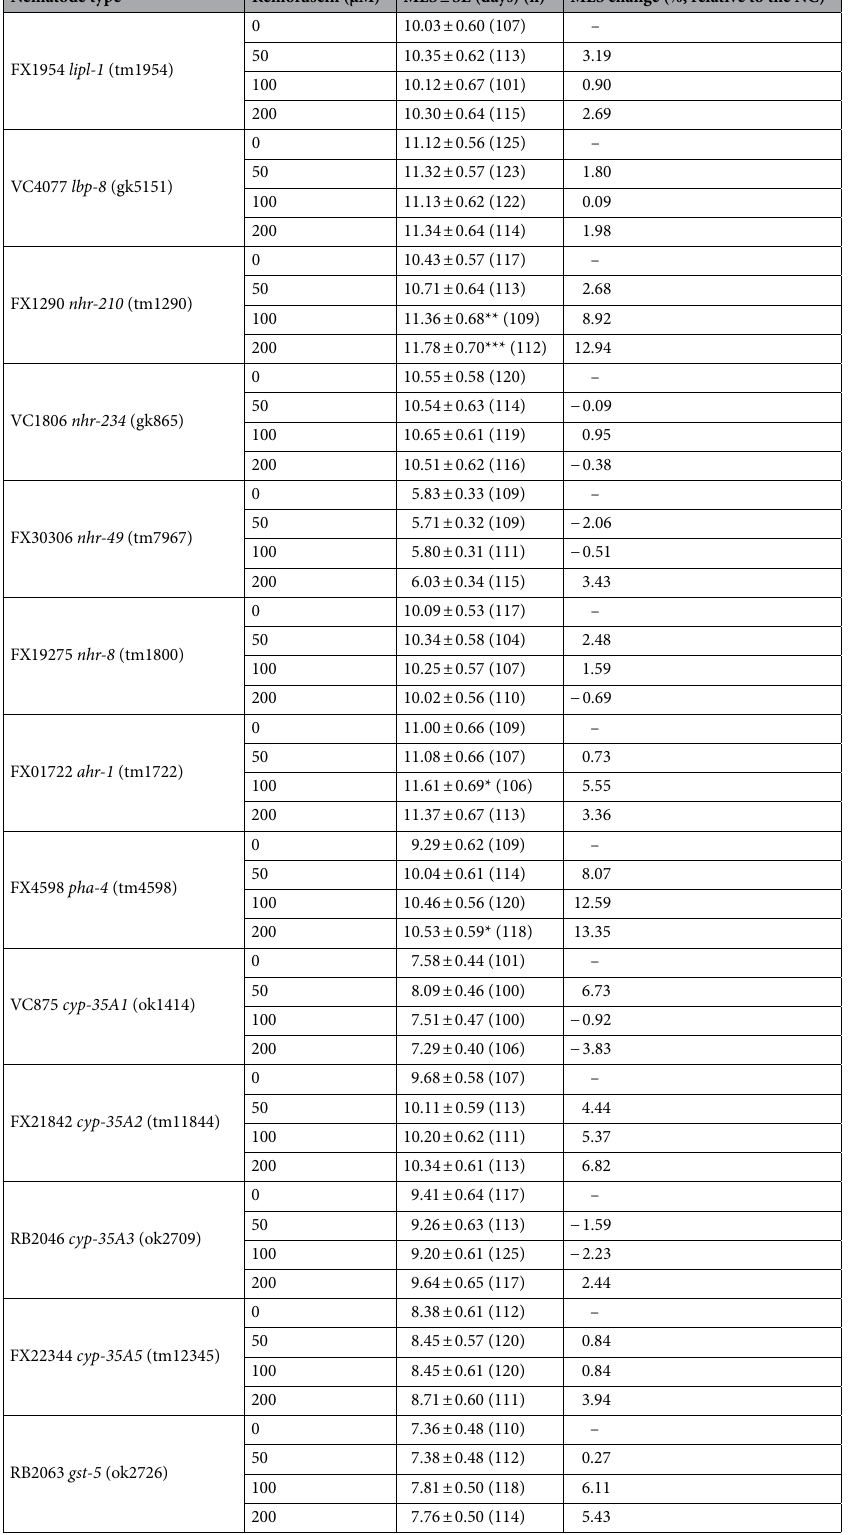
Table 2. The mean lifespans of C. elegans with loss-of-function mutants. All experiments were conducted three times independently. n, The number of total worms; * p < 0.05, ** p < 0.01, *** p < 0.001, log-rank test, compared with the NC (0 μM